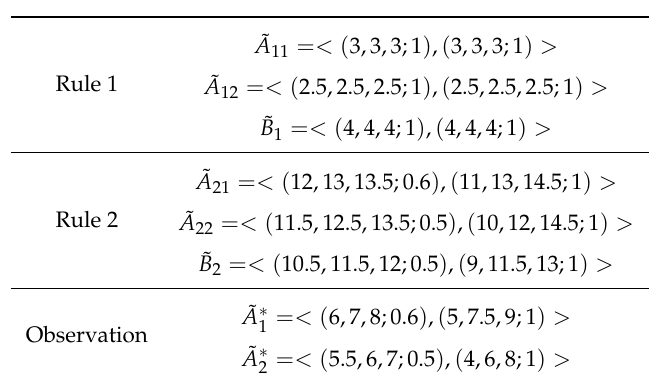
Table 2. Involved interval type-2 fuzzy sets for Case 2.